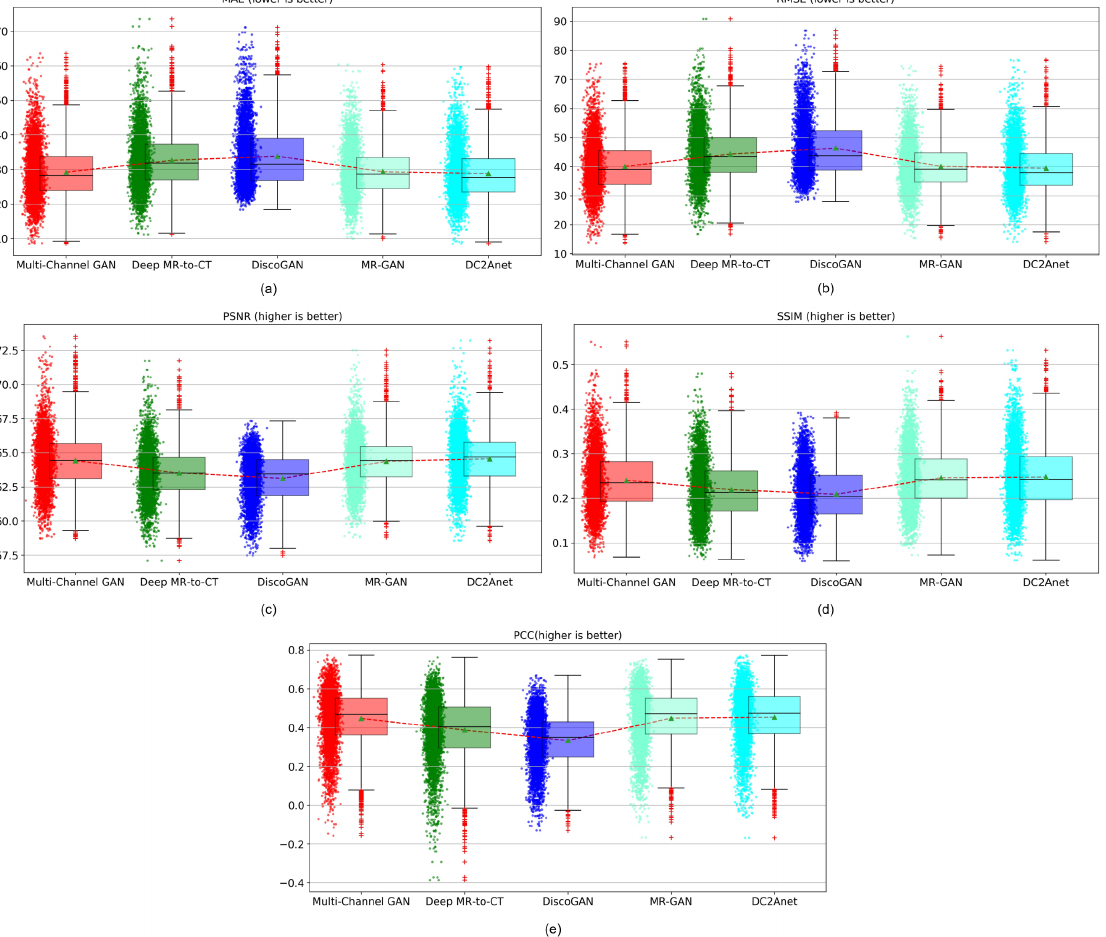
Figure 6. A comparison of the proposed approach with baseline methods based on ( a ) MAE, ( b ) RMSE, ( c ) PSNR, ( d ) SSIM, and ( e ) PCC